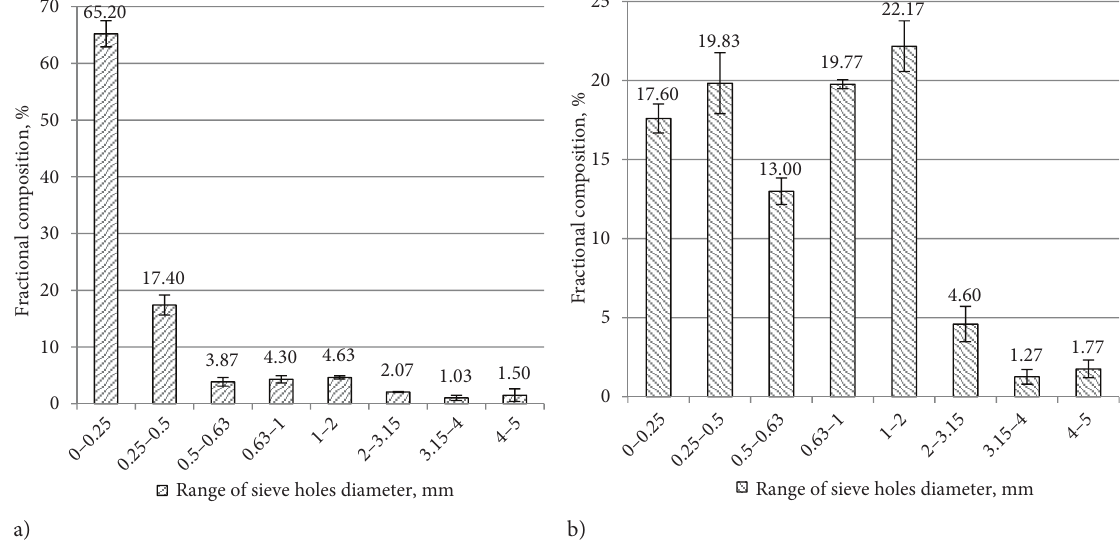
Figure 1. Particle size of fractional composition of the raw material (mill) a) for granules IP and GA production and b) for granules KA